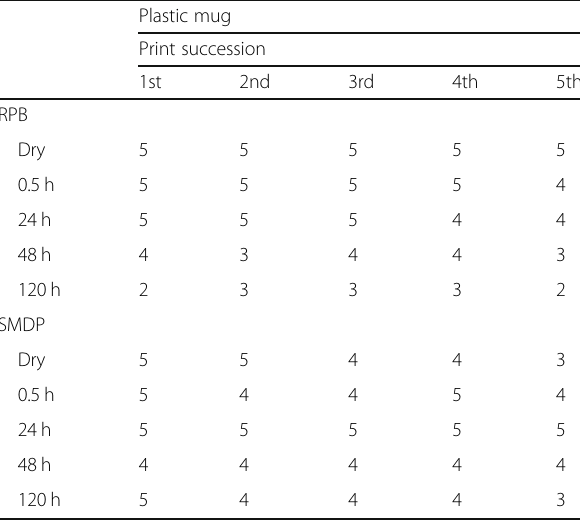
Table 2 Development of submerged and successive prints on laminated paper using Robin powder blue and silver magnetic dual powder